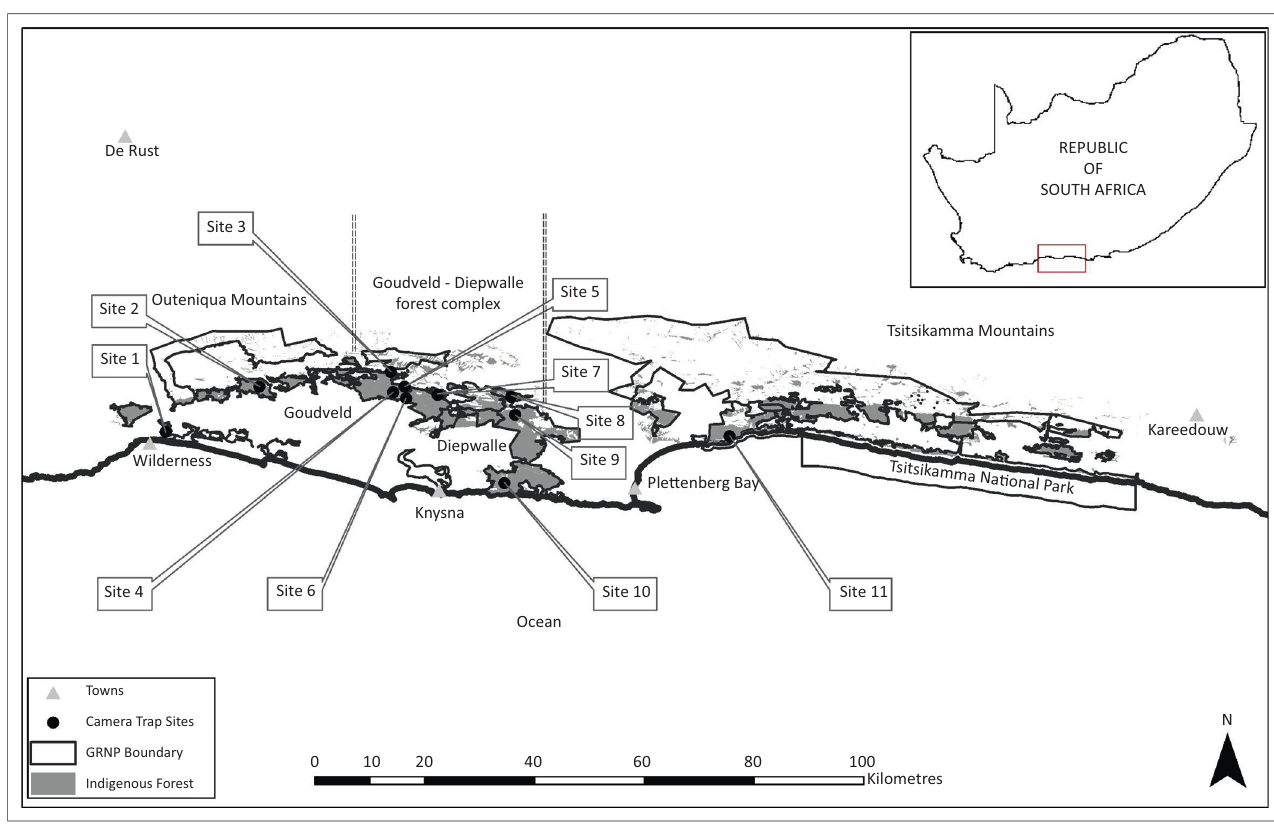
FIGURE 1: Map of the Southern Cape showing the location of the Garden Route National Park, its indigenous forests and camera trap